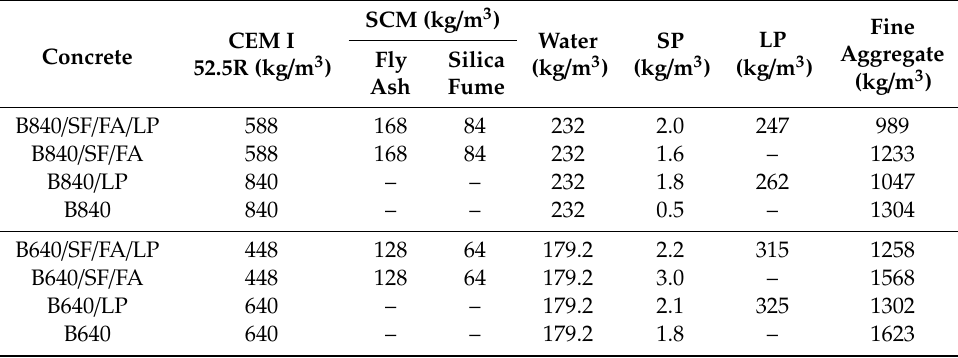
Table 1. Composition and notification of concrete